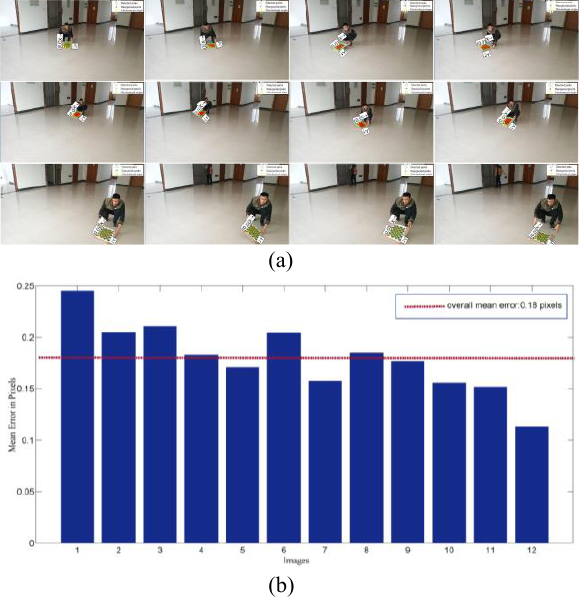
Figure 6 . Camera calibration: (a) Pictures for camera calibration, (b) Camera calibration error of each picture.